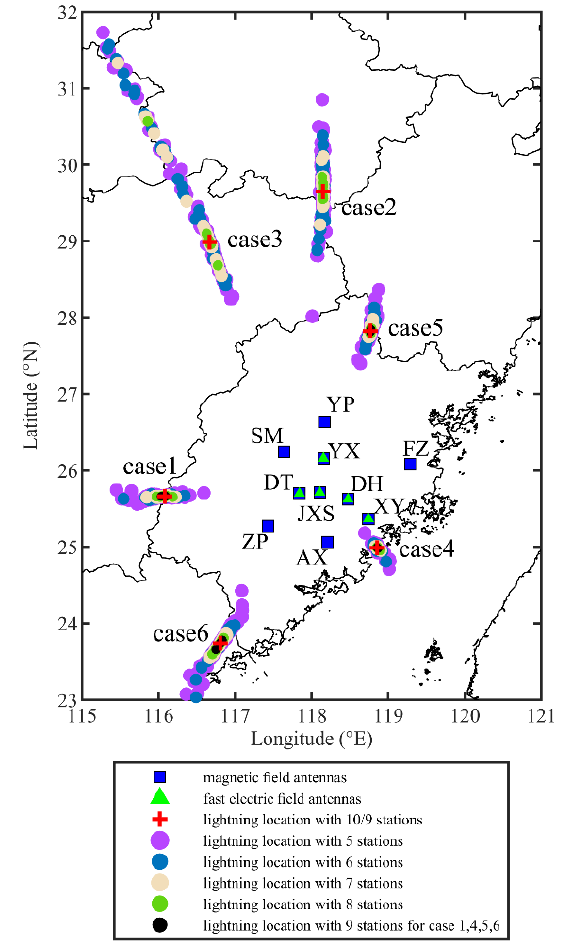
Figure 7. The spatial distribution of locations under different numbers and configuration of participating stations. The red crosses represent the reference location, obtained by 10/9 stations. The purple, blue, misty rose, green, and black dots represent the locations obtained by 5, 6, 7, 8, 9 stations, respectively.